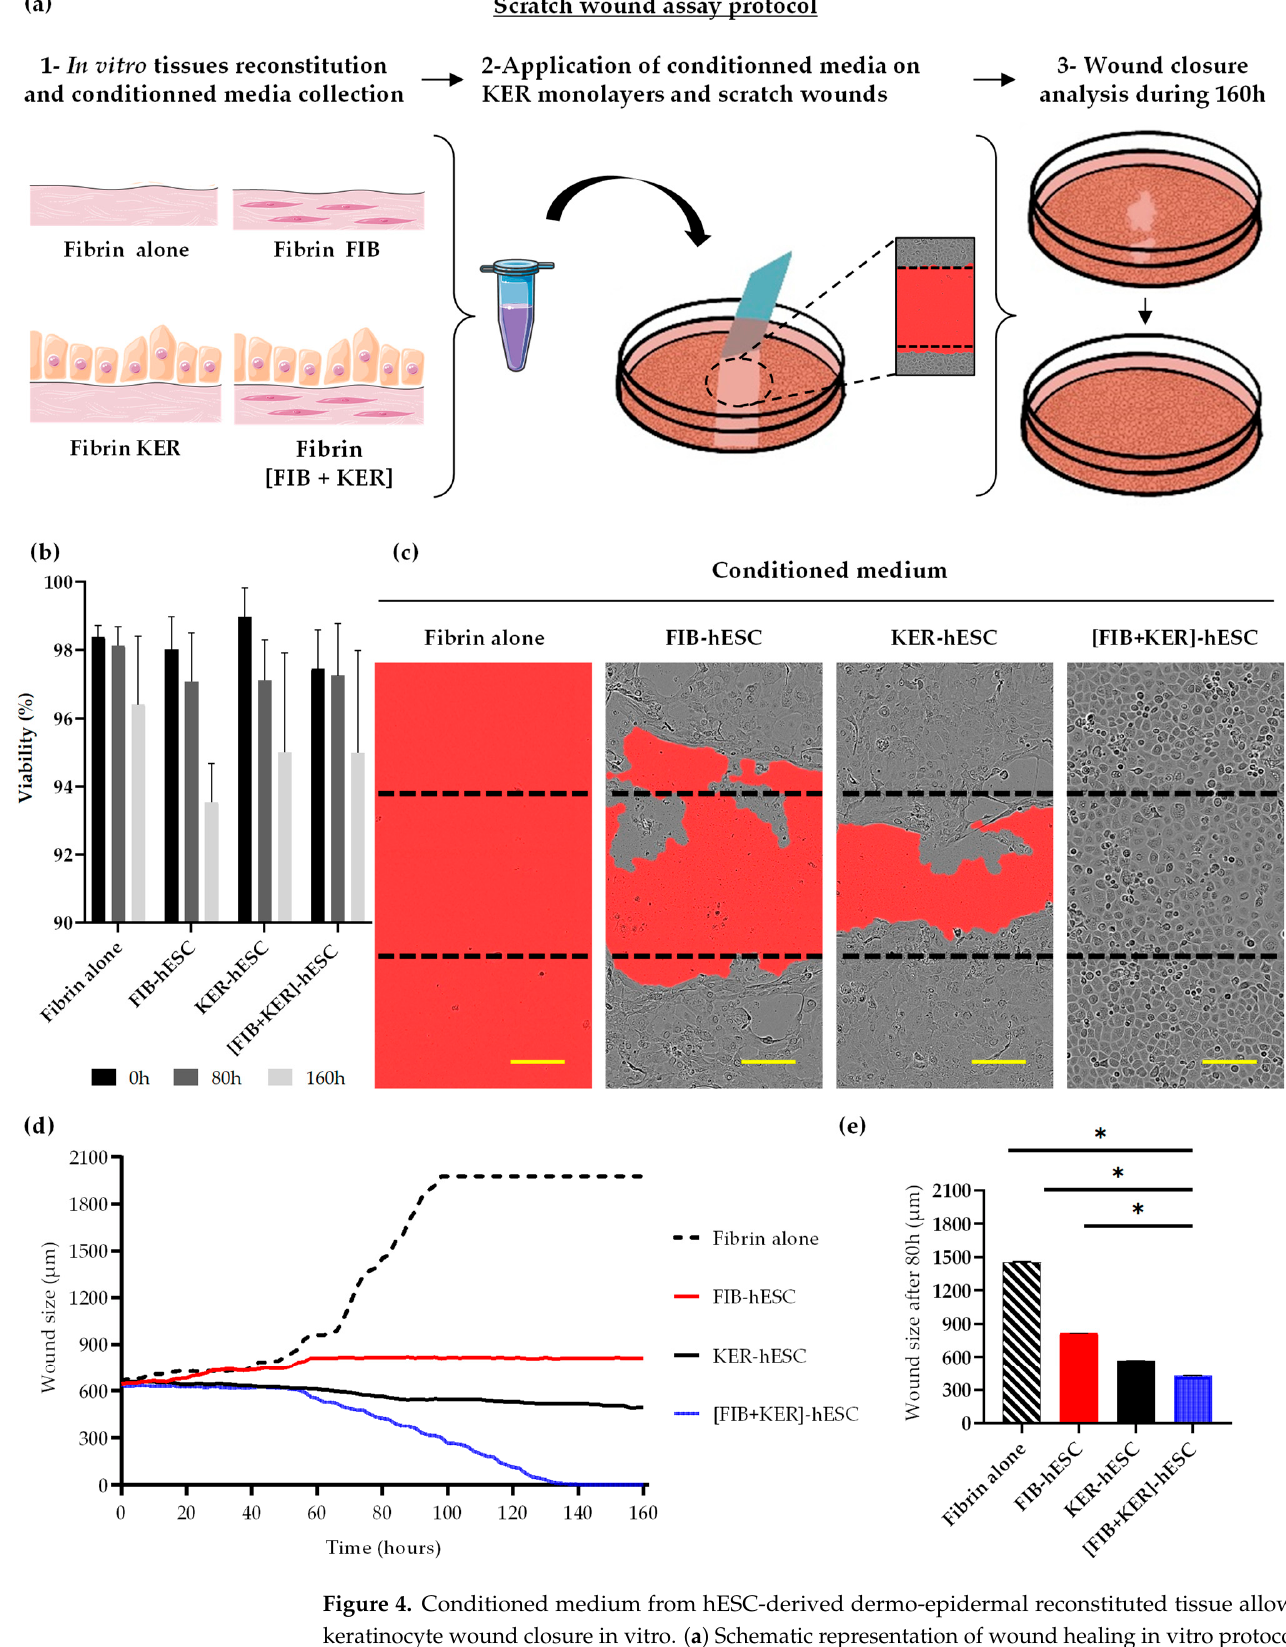
Figure 4. Conditioned medium from hESC-derived dermo-epidermal reconstituted tissue allows keratinocyte wound closure in vitro. ( a ) Schematic representation of wound healing in vitro proto- col. After preparation of in vitro tissues (Fibrine alone, KER alone or FIB alone or [KER + FIB]), conditioned media were collected and applied on keratinocyte monolayers (at T = 0 h). Then, the